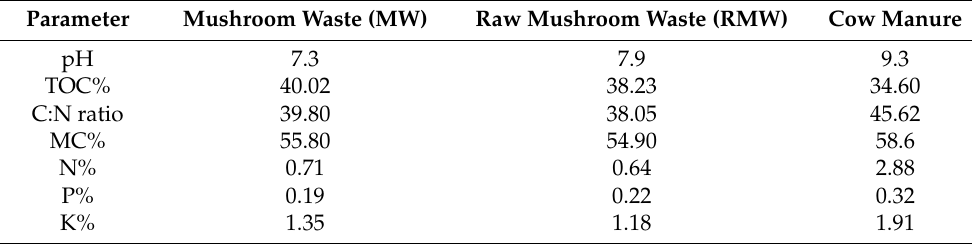
Table 2. Initial characteristics of the materials used for the experiment. Parameter Mushroom Waste (MW) Raw Mushroom Waste